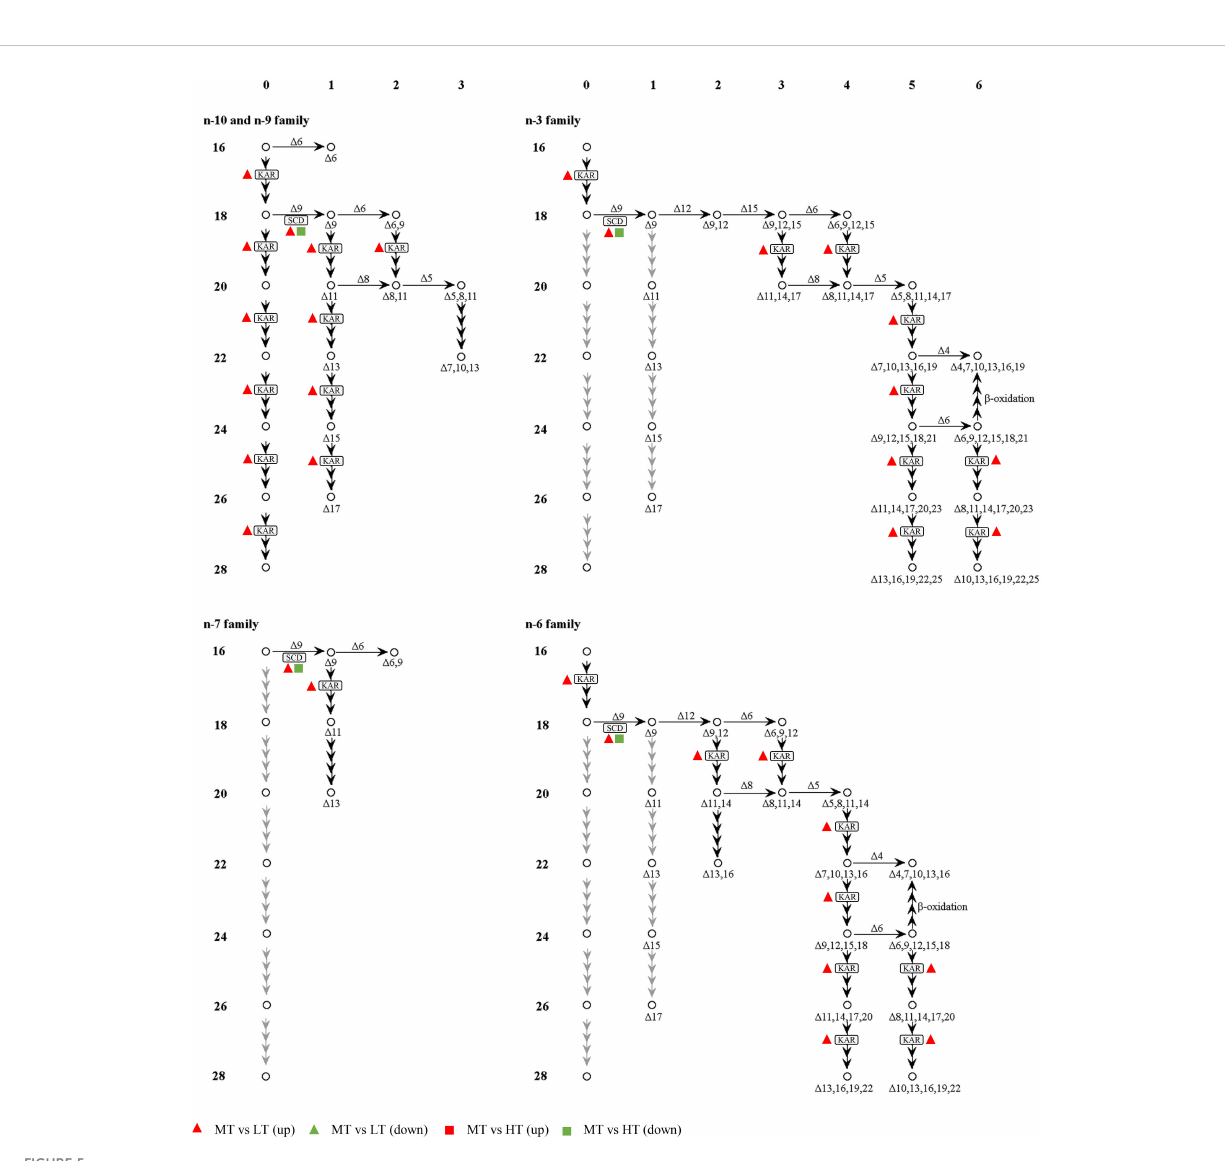
FIGURE 5 Pathways of biosynthesis of unsaturated fatty acids. The left side and top of the fi gure show the number of carbon atoms (16~28), and number of double bonds (1~6), respectively. The detailed descriptions of the DEGs are included in Supplementary Table